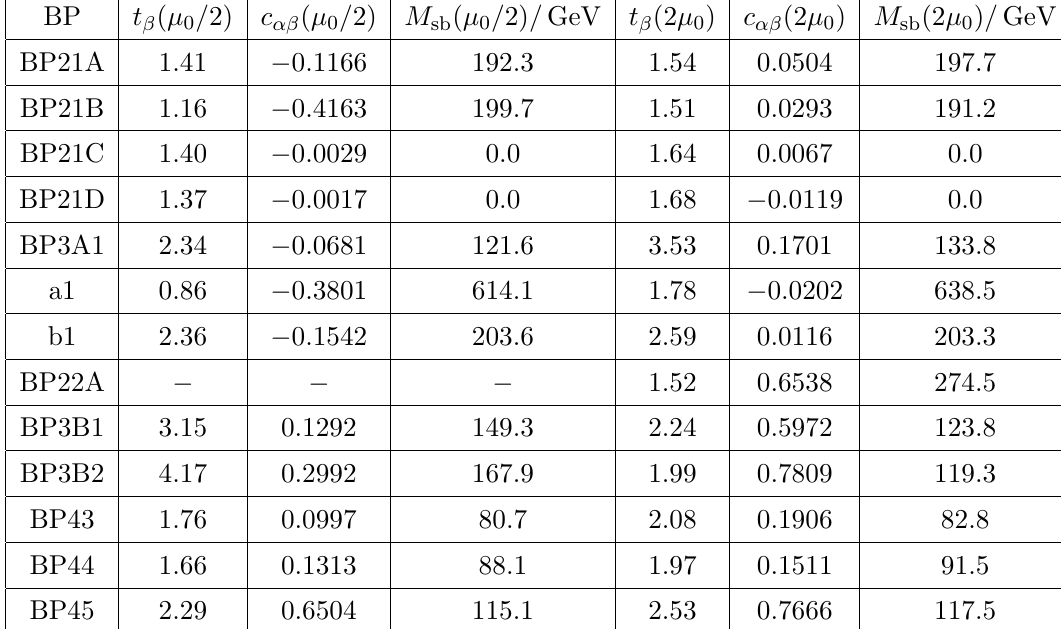
Table 6. Running values for t (cid:12) , c (cid:11)(cid:12) and M sb in the 2HDM at the scales (cid:22) 0 = 2 and 2 (cid:22) 0 . The benchmark points are de(cid:12)ned at the central scale (cid:22) 0 in tables 1 and 3. The results for the alignment- limit scenarios are in the upper part of the table whereas the non-alignment scenarios are in the lower part. For BP22A the running (cid:12) reaches (cid:25)= 2 for a scale greater than (cid:22) 0 = 2, thus, t (cid:12) becomes singular. In this particular scenario the steep running is caused by the Higgs self-coupling (cid:21) 3 and can be stabilized by reducing its value. The running becomes stable only for values smaller than (cid:21) 3 . 0 : 5. Changing (cid:21) 3 to 0 : 5 and keeping the values for all other (cid:21) i (cid:12)xed has a small e(cid:11)ect on M H and M H of the order (5 GeV), but brings the scenario close to the alignment limit c (cid:11)(cid:12) l h O